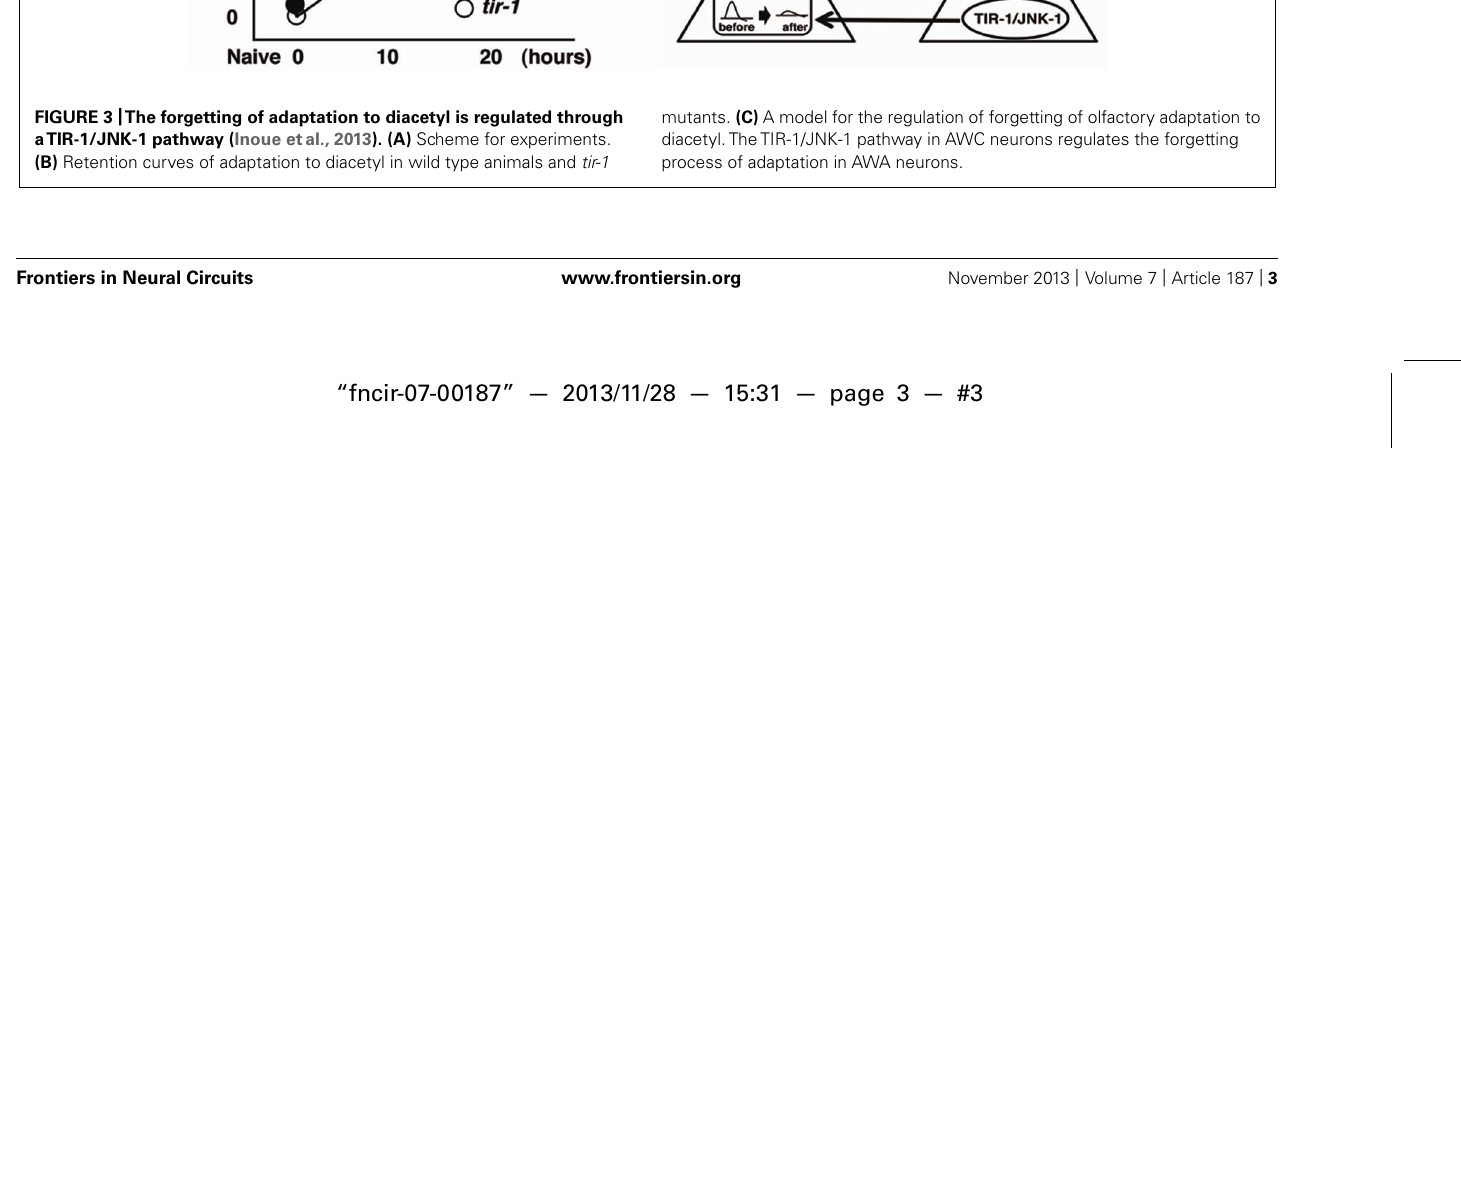
FIGURE 3 |The forgetting of adaptation to diacetyl is regulated through aTIR-1/JNK-1 pathway (Inoue etal., 2013). (A) Scheme for experiments. (B) Retention curves of adaptation to diacetyl in wild type animals and tir-1